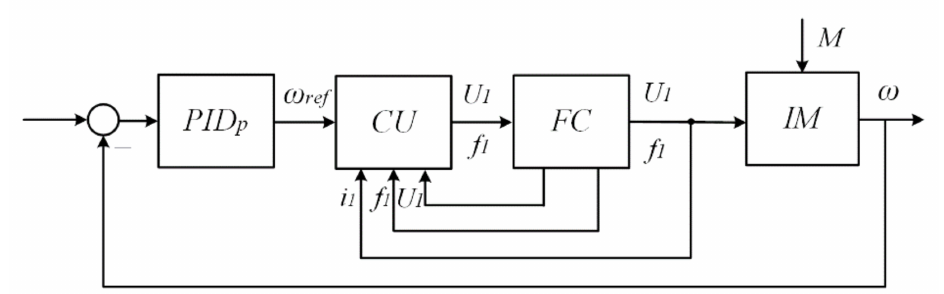
Figure 5. Structural scheme of an asynchronous electric drive with vector control and